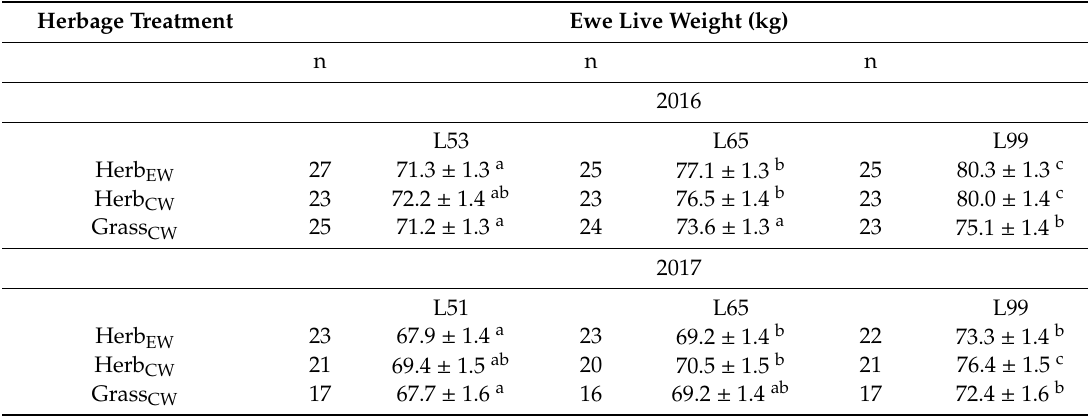
Table 3. Live weight of ewes in Herb EW , Herb CW and Grass CW treatments at L53, L65 and L99 in 2016 and at L51, L65 and L99 in 2017 (least-squares mean ± SEM). Herbage Treatment Ewe Live Weight